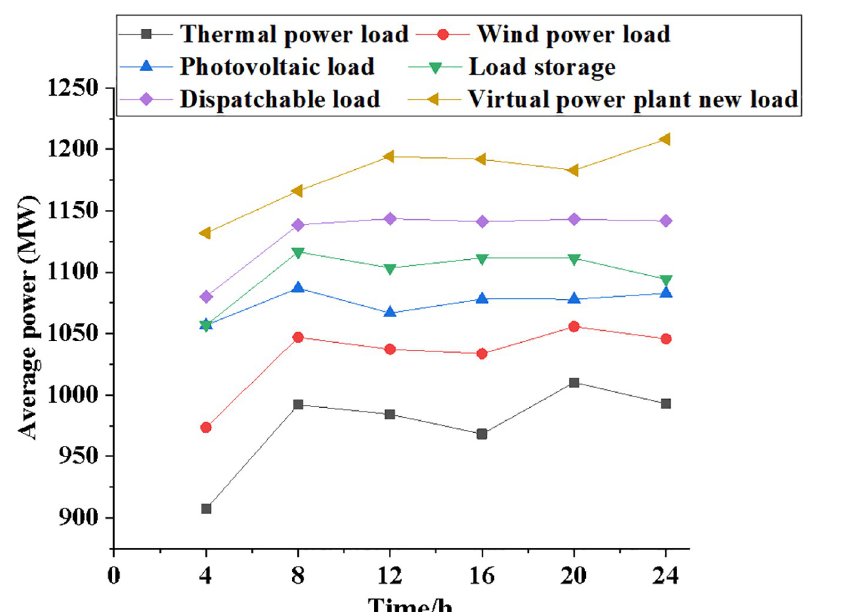
Fig 5. Comparison of average power changes of different electric load types.